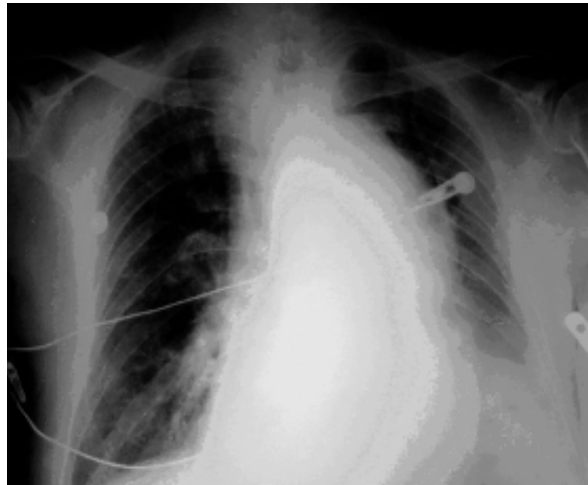
Fig.1 - Radiografia de tórax no pré-operatório.